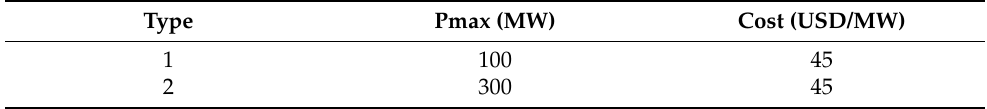
Table 9. Types of